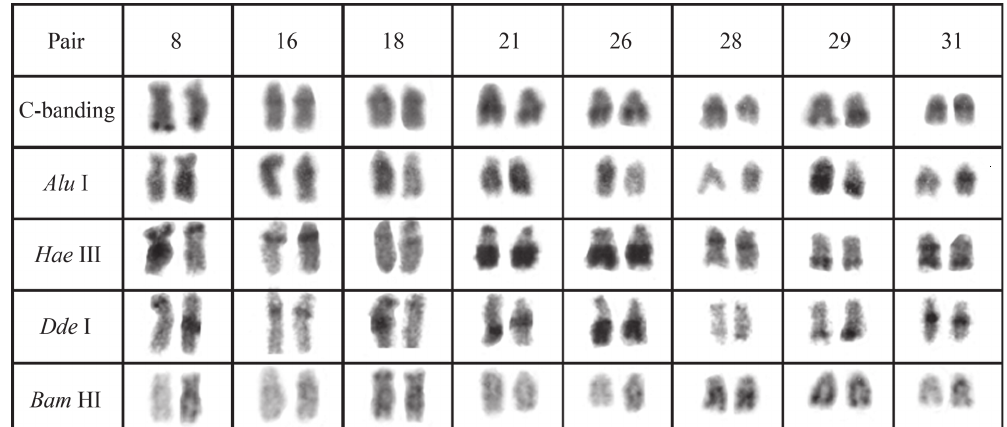
Fig. 2. Chromosomal pairs of Hypostomus cf. wuchereri from Mutum River showing the C-bands and the digestion profiles using Alu I, Hae III, Dde I, and Bam HI.